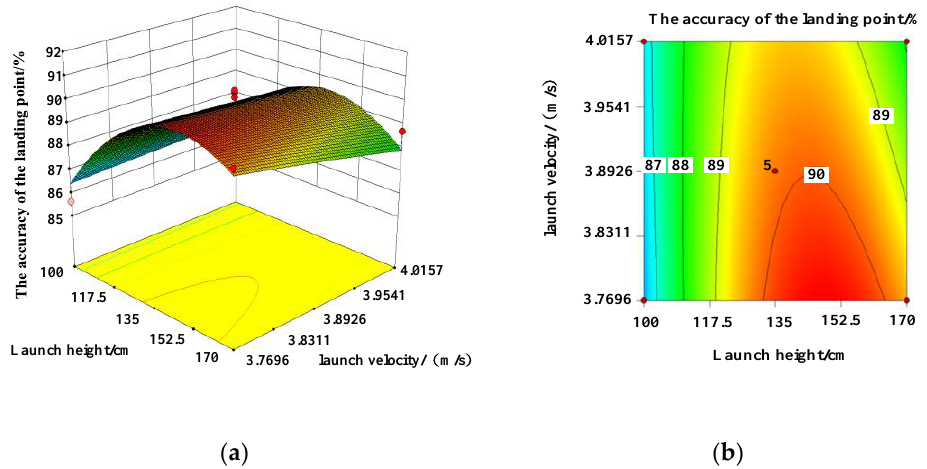
Figure 4. ( a ) Response surface and ( b ) contour plot for the interaction between launch height and launch velocity on landing accuracy. ( a ) Response surface; ( b ) contour lines.